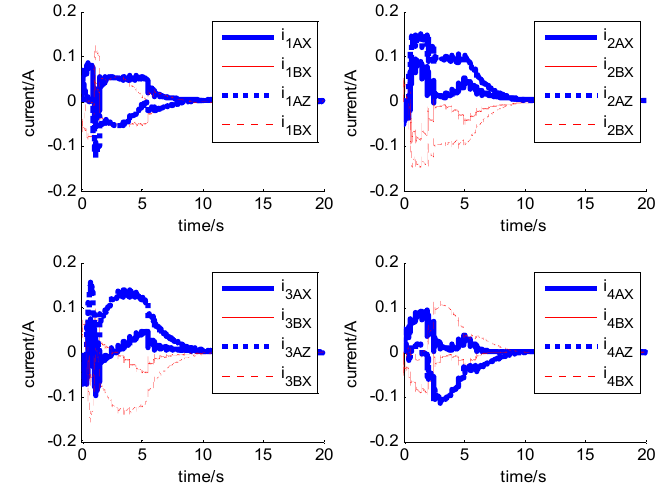
Figure 19. The magnetically suspended rotor control current with feedforward